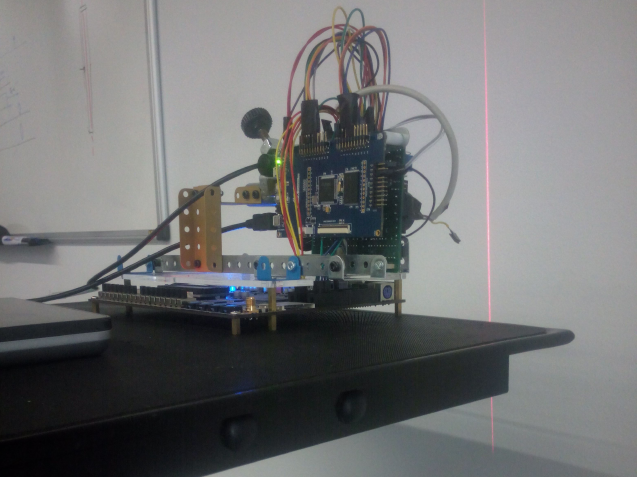
Figure 9. System on the upper part of a wheeled cart in the approaching wall experiment.